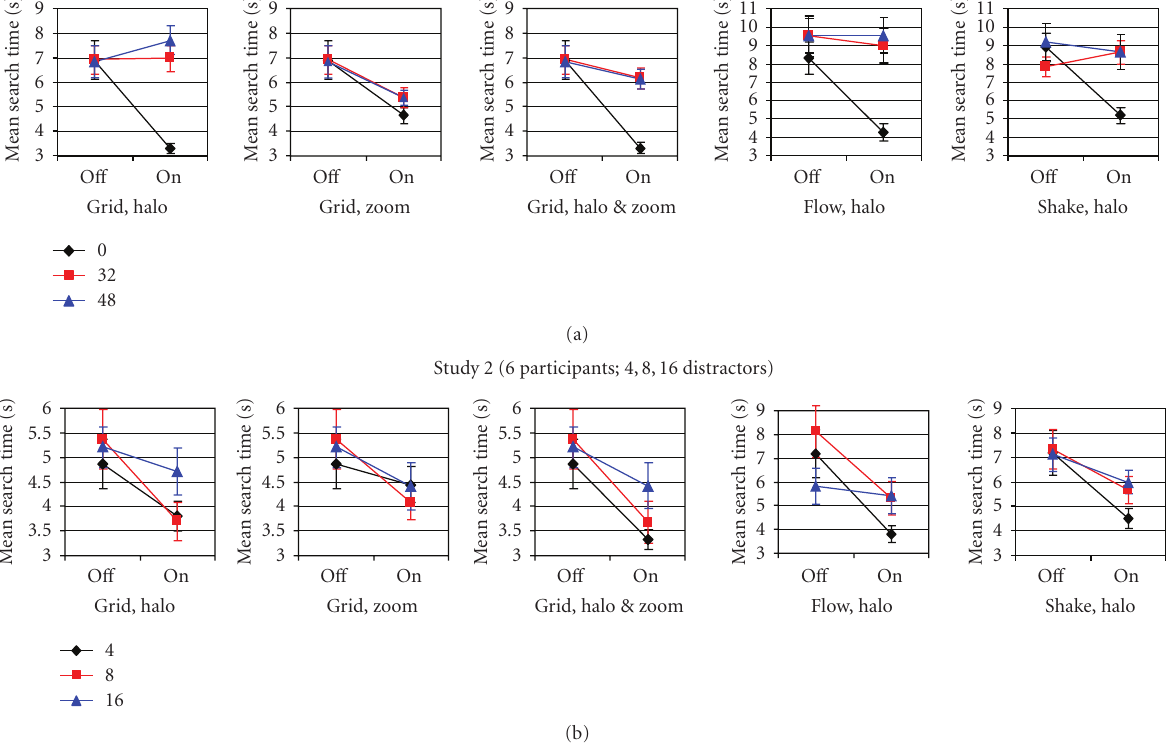
Figure 7: Change in performance as di ff erent visualization techniques are enabled for di ff erent numbers of distractors. For study 1, an interaction between the number of distractors and halo, but not zoom, is